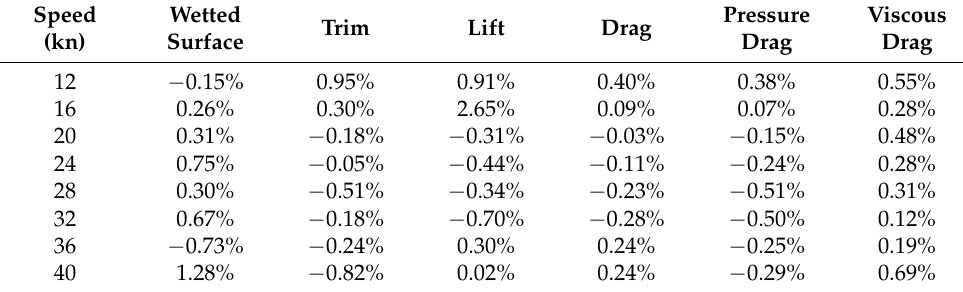
Table 7. Relative variation/difference of global quantities.